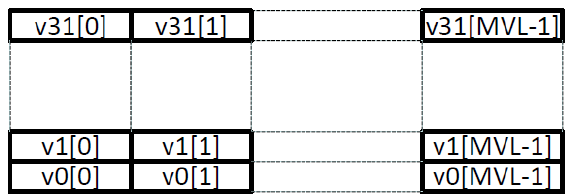
Fig. 2. The structure of vector registers.